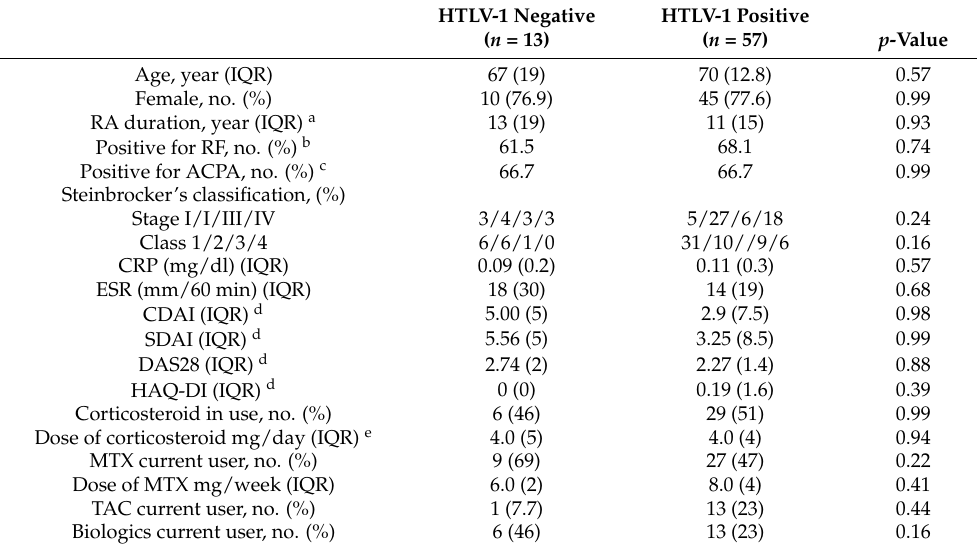
Table 1. Characteristics of HTLV-1-negative and -positive participants with RA.